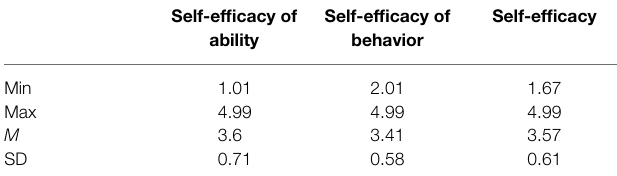
TABLE 2 | Overall description of entrepreneurial